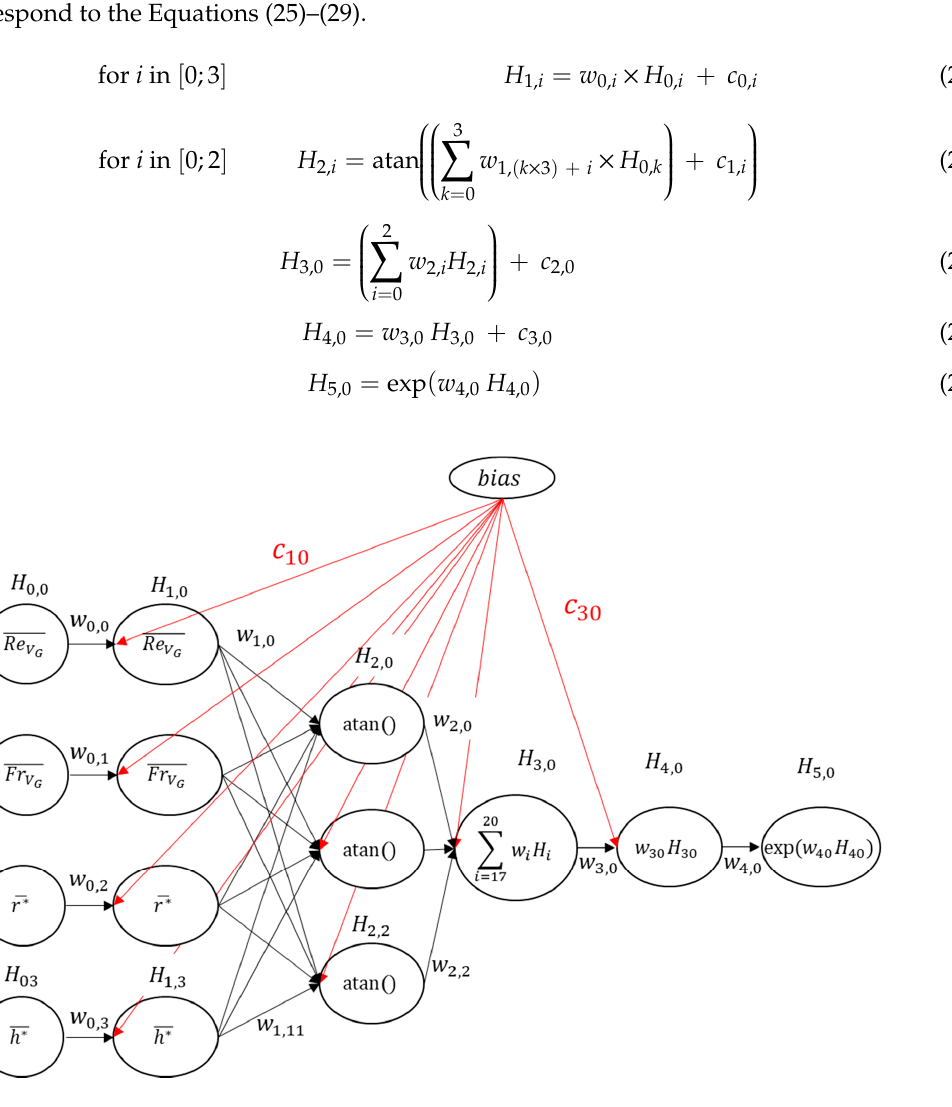
Figure 3. Results of the training of the artificial neural network (ANN), the results of void fraction of the ANN 𝜀 (cid:3002)(cid:3015)(cid:3015) are compared to the void fraction calculated to 𝜀 (cid:3033)(cid:3039)(cid:3048)(cid:3032)(cid:3041)(cid:3047) . The blue points represent the learning samples and the red points the validation samples. The red line is 𝜀 (cid:3033)(cid:3039)(cid:3048)(cid:3032)(cid:3041)(cid:3047) + 40% and the blue line 𝜀 (cid:3033)(cid:3039)(cid:3048)(cid:3032)(cid:3041)(cid:3047) − 40%. 2.2.2. Sensitivity Analysis of Void Fraction and Ohmic Resistance In order to observe the effect of the different parameters on the electrolysis performance, the artificial neural network has been used to predict the void fraction 𝜀 and the electrolyte ohmic resistance 𝑅 . Therefore, we performed a fractional factorial design of experiment (DOE). The DOE used is a “one factor at a time” (OFAT), referred to the minimal parameter-values curve (red). In all other curves, a single parameter among (T, Y, j, H, and h) changes from min to max value to assess